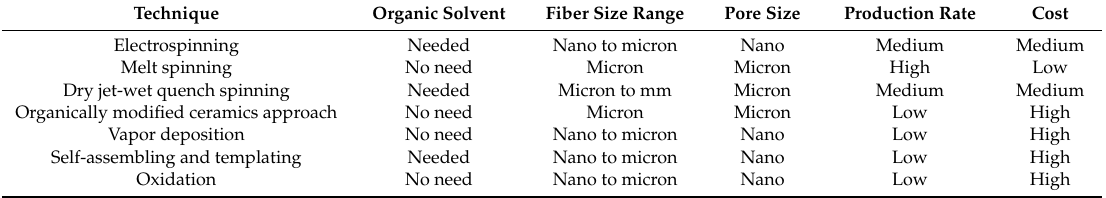
Table 1. Advantages and Disadvantages of Various Porous Fiber Processing